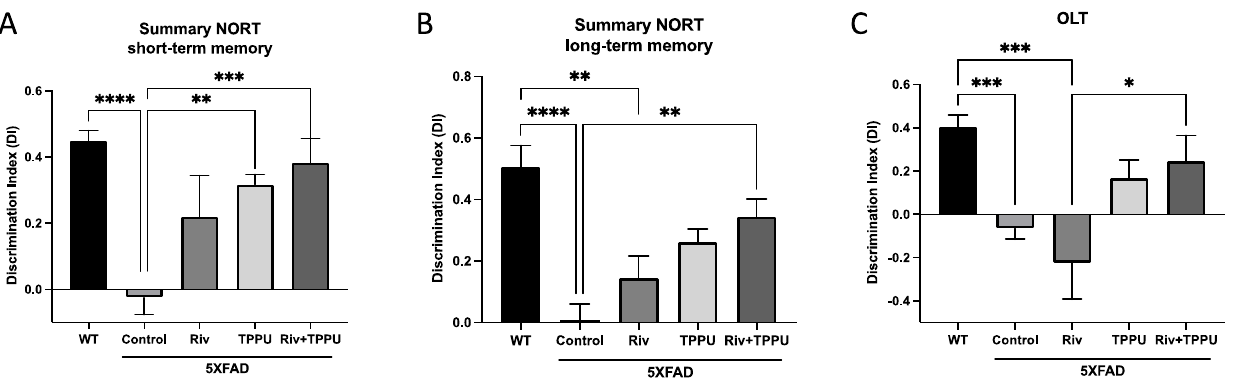
Figure 4. Effects of drug combination and monotherapies on cognitive performance in 5XFAD mice. ( A ) Short-term memory test at 2 h. ( B ) Long-term memory test at 24 h. ( C ) OLT. Results are expressed as a mean ± SEM. Groups were compared by the one-way ANOVA test and post-hoc Tukey’s test. WT, n = 12; 5XFAD control, n = 10; 5XFAD treated with TPPU (1 mg/kg/day), n = 8; 5XFAD treated with Riv (1 mg/kg/day), n = 8; 5XFAD subjected to co-treatment with TPPU (1 mg/kg/day) plus Riv (1 mg/kg/day), n = 8. * p < 0.05; ** p < 0.01; *** p < 0.001; **** p < 0.0001.